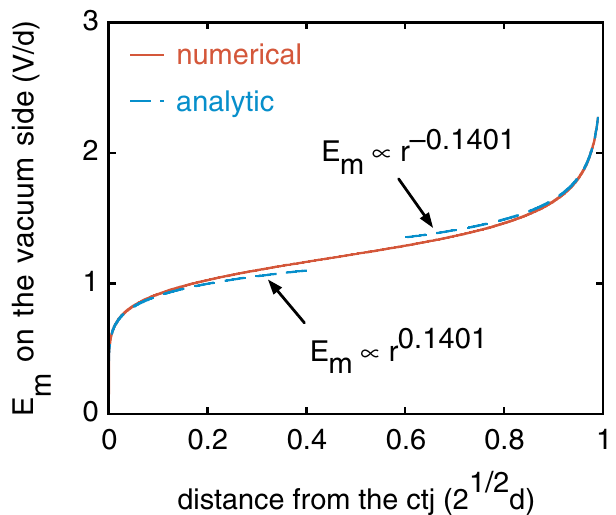
FIG. 6. (Color) The characteristic value of E FIG. 5. (Color) The absolute value of the electric-field magni- and cathode triple junctions for the idealized 45 (cid:1) vacuum- as a function of distance along the vacuum-insulator tude E m insulator interface outlined in Figs. 1 and 2. Plotted is the field interface of the idealized 45 (cid:1) system outlined in Figs. 1 and 2. on the vacuum side of the interface as a function of the dielectric The field is that on the vacuum side of the interface, and assumes constant " . We arbitrarily define the characteristic field to be that that the dielectric constant of the insulator " (cid:8) 2 : 55 . The plots at the interface, at a distance (cid:2) 0 : 01 (cid:4) 2 1 = 2 d from a junction. compare the field obtained numerically with those given analyti- cally by Eqs. (1)–(3). [The numerical result is identical to that / r (cid:10) 0 : 1401 is nor- (vac) in Fig. 3.] The relation E labeled E m m malized to the numerical result at a distance 0 : 01 (cid:2) 2 1 = 2 d (cid:4) from the / r 0 : 1401 is normalized at a anode triple junction; the relation E m distance 0 : 01 (cid:2) 2 1 = 2 d (cid:4) from the cathode